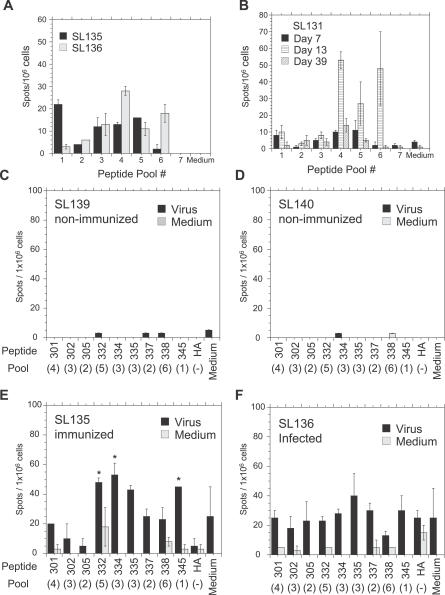
Ex Vivo IFN-γ Response of T Cells in Peripheral Blood to Vaccinia PeptidesResponse in PBMCs isolated from vaccinia-exposed donors and from non-exposed donors to pools of vaccinia peptides or individual peptides, measured by IFN-γ ELISPOT.(A) IFN-γ responses of PBMCs in an immunized donor (SL135) and in an infected donor (SL136). No spots were observed in control wells (cRPMI+10% HS, no peptide). (B) Kinetics of the IFN-γ response after a boosting immunization of donor SL131, a DR1 donor. Spots for control wells (cRPMI+10% HS, no peptide) day 7 4+/−1, day 13 1+/−1, and day 39 0+/−0 (C–F) IFN-γ responses in PBMCs after depletion of CD8+ T and overnight incubation in cRPMI+10% HS (gray bars) or incubation in cRPMI+10% HS supplemented with a crude preparation of heat-inactivated vaccinia virus (solid bars). (C, D) non-immunized donors SL139 and SL140. (E, F) vaccinia-immunized donors SL135 and SL136. Spots in control wells (Medium, no peptide) 25+/−20. Statistically significant responses (p <0.05) indicated by an asterisk.